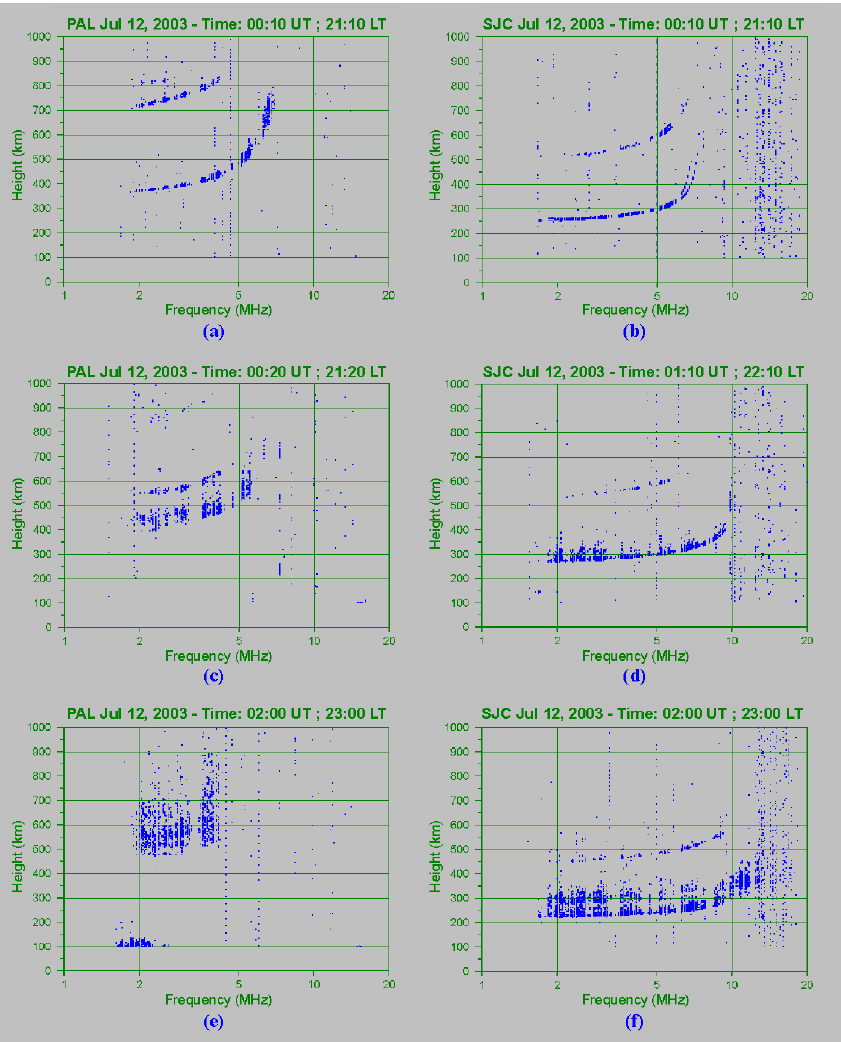
Fig. 5. Examples of ionograms obtained at Palmas and Sao Jose dos Campos on the night of 11–12 July